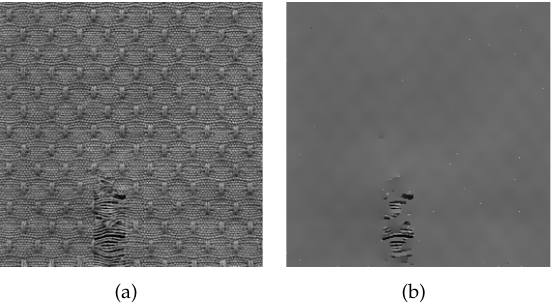
Figure 3. Smoothed background texture information via the L 0 Gradient Minimization (LGM). ( a ) Input fabric image; ( b ) Smoothed fabric image.